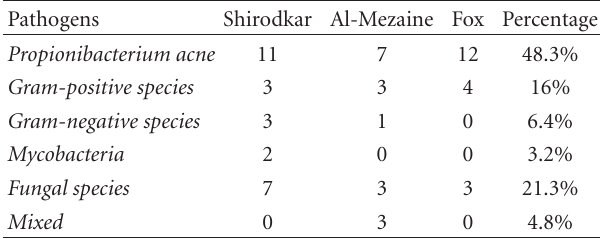
Table 2: Percentage of organisms reported in di ff erent case series of chronic postoperative endophthalmitis [5, 18,